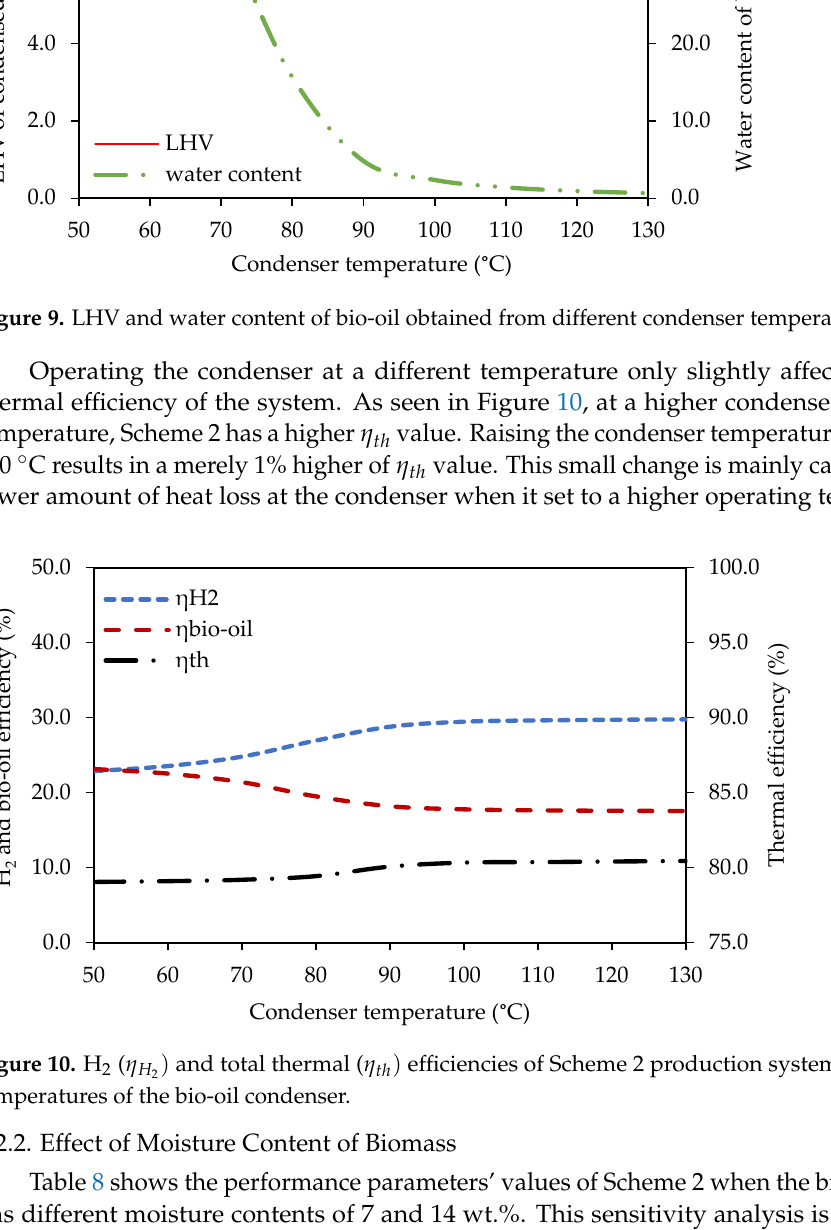
Figure 10. H 2 ( η H ) and total thermal ( 𝜂 𝑡ℎ ) efficiencies of Scheme 2 production system at different temperatures of the bio-oil condenser.